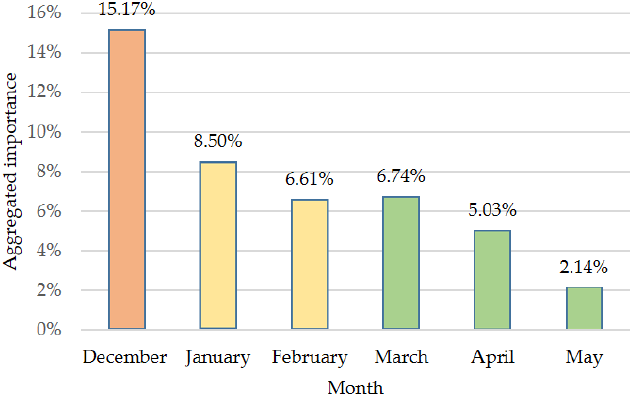
Figure 4. Relative importance by month obtained from the variable selection stage and sorted according to their aggregated scores (each color represents a similar amount of aggregated importance).